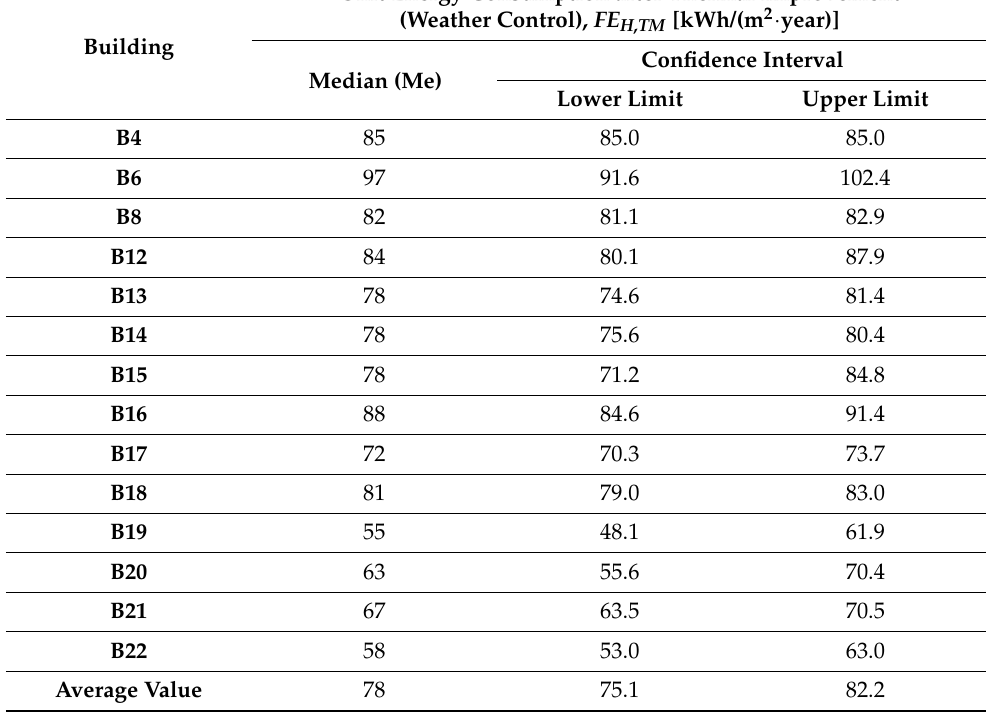
Table 7. Index of annual energy consumption after thermal improvement of buildings, but with the